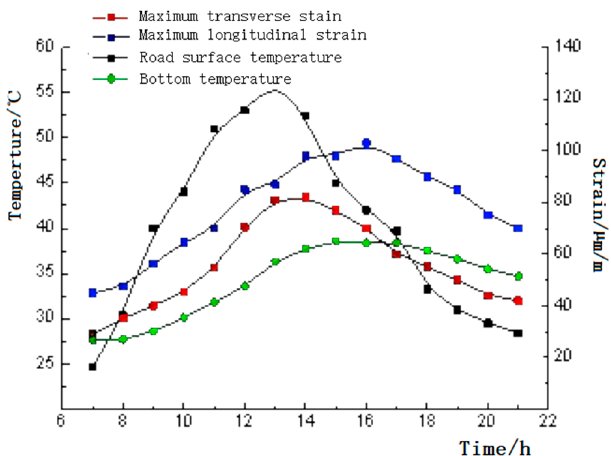
Figure 7. Structure B temperature versus maximum transverse and longitudinal tensile strain at the base of the layer.